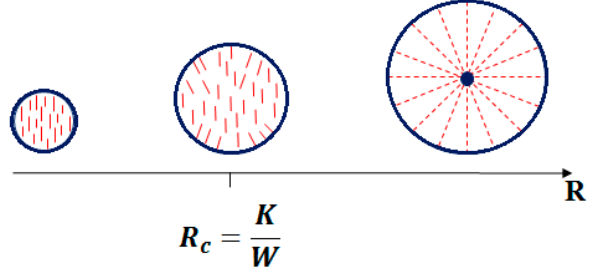
Figure 4. Schematization of a nematic liquid crystal drop with homeotropic surface anchoring conditions and varying size.